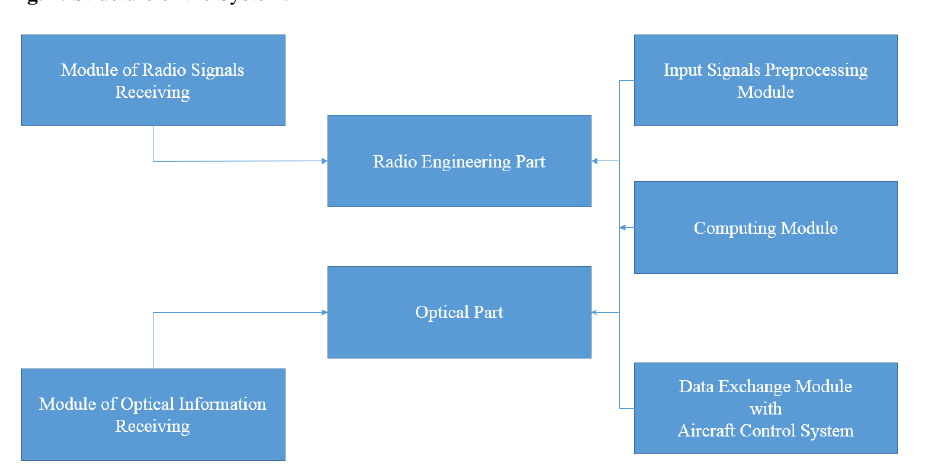
Fig. 1. Structure of the System.